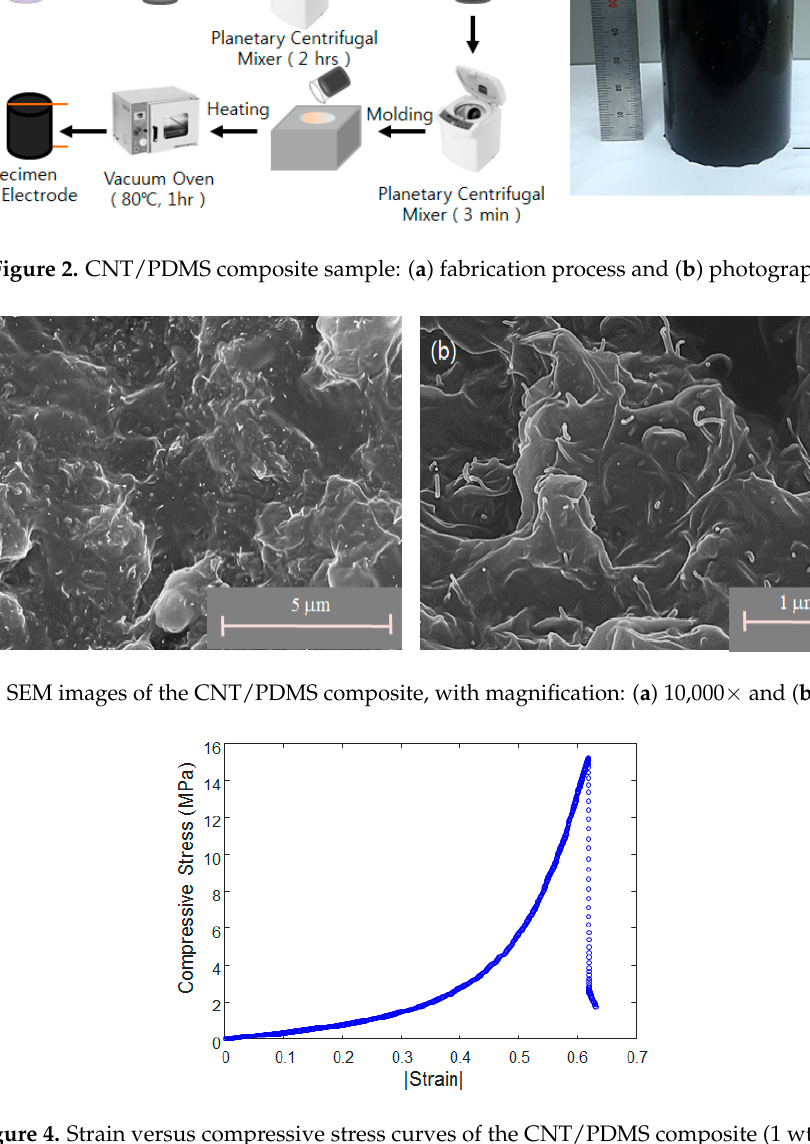
Figure 4. Strain versus compressive stress curves of the CNT/PDMS composite (1 wt %).